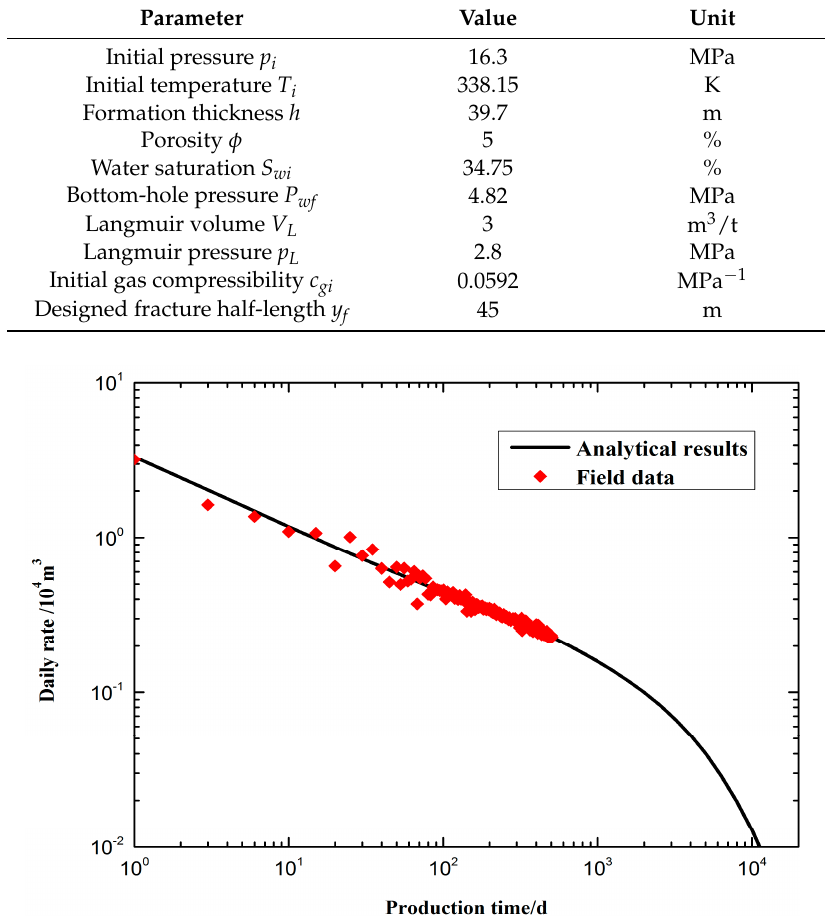
Figure 14. Log-log decline curve for field example.